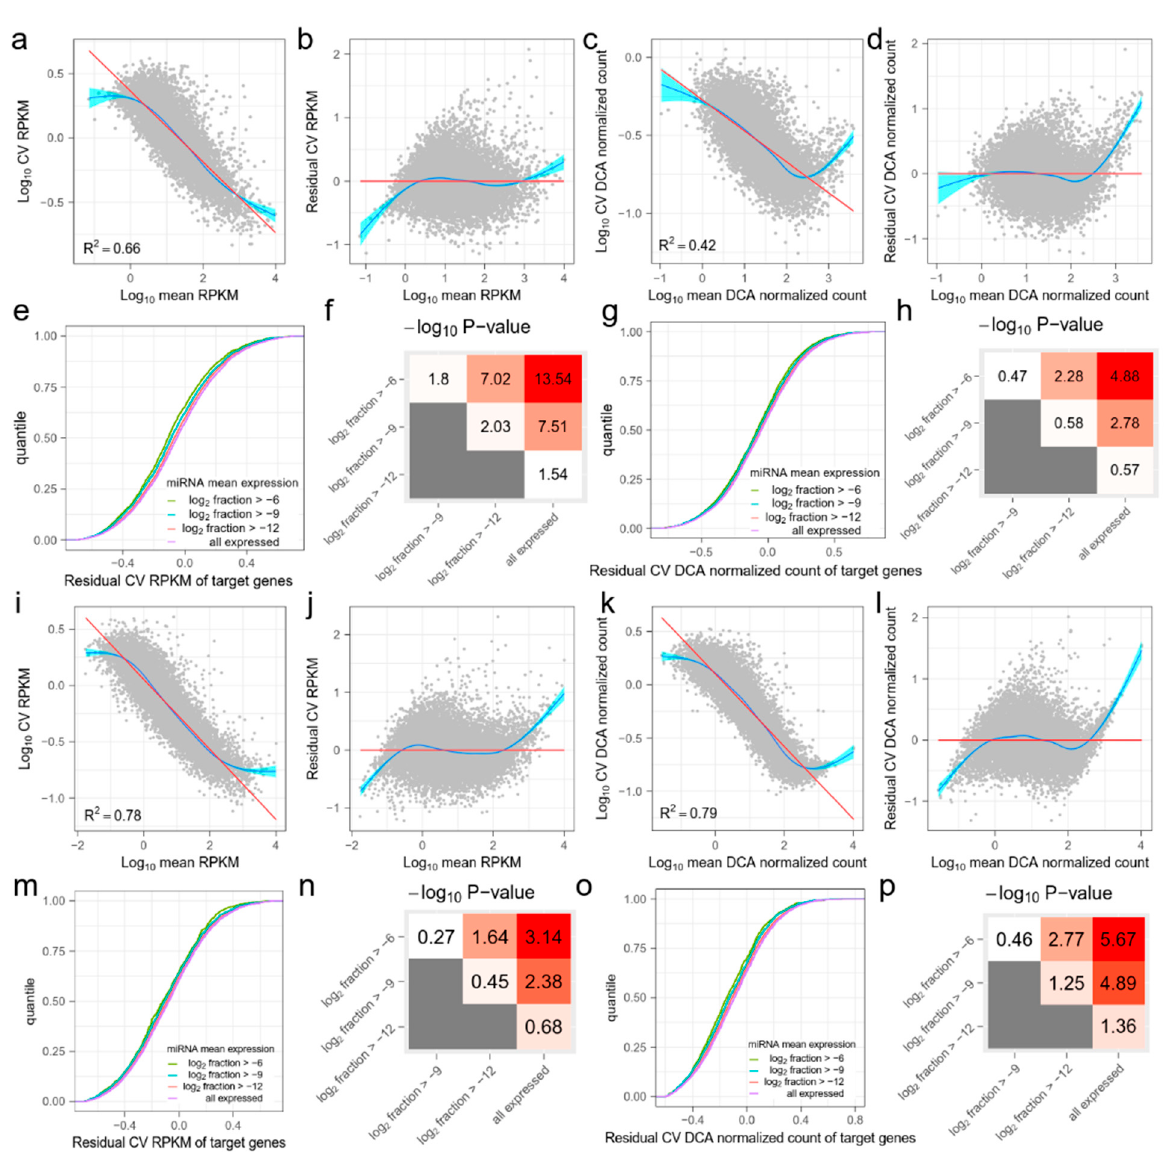
Figure A1. The effect of miRNA on the target mRNAs in ( a – h ) GSE81287 naive ESCs and ( i – p ) GSE114071 K562 cells. The organization of this figure is the same as for Figure 1. ( a , i ) The mean and coefficient of variation (CV) of RPKM values of mRNAs. The red line is fitted by ordinary least squares regression and the blue line is fitted by the smoothing method, Generalized Additive Models. ( b , j ) Mean and residual CV (RCV) RPKM values of mRNAs. ( c , k ) Mean and CV DCA normalized counts of mRNAs. ( d , l ) Mean and CV DCA normalized counts of mRNAs. ( e , m ) Cumulative distribution functions (CDFs) of RCV RPKM of target genes. Target genes are grouped by miRNA mean expression levels. As the miRNA mean expression level increases, the RCV RPKM of their target genes significantly decreases. ( f , n ) Kolmogorov–Smirnov (KS)-test − log10 ( p ) values between CDFs in ( e , m ). Red indicates higher statistical significance and white indicates lower statistical significance. ( g , o ) CDFs of RCV DCA normalized count of target genes. Target genes are grouped by miRNA mean expression levels. ( h , p ) KS-test − log10 ( p ) values between CDFs in ( g , o ). Red indicates higher statistical significance and white indicates lower statistical significance.